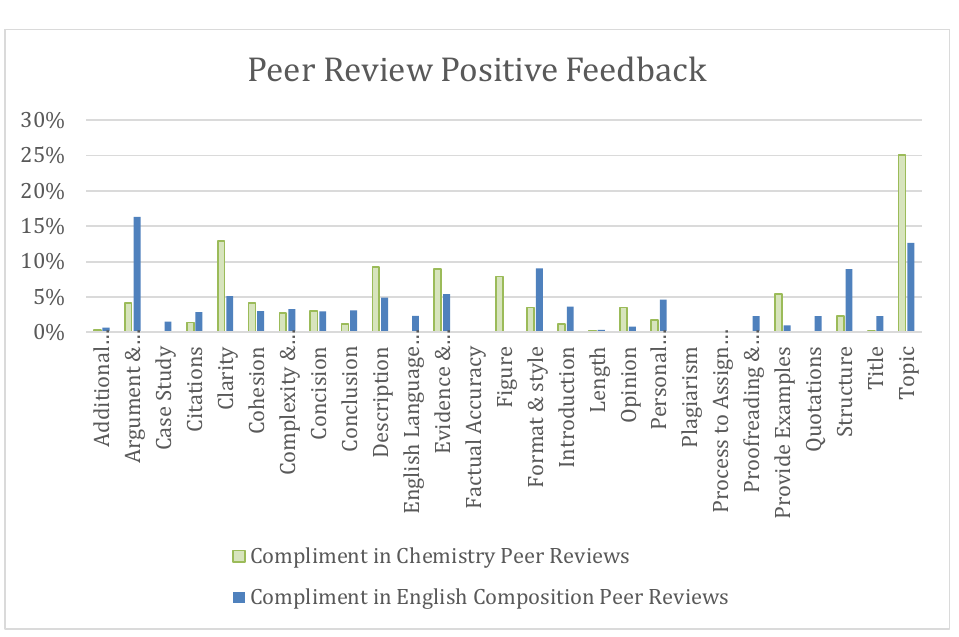
Figure 6. Positive feedback writing elements in peer review open ended questions by course 16